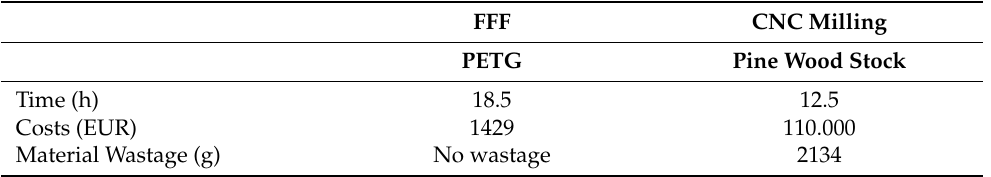
Table 4. Comparison between costs of CNC milling and FFF for the production of a column of the 17th-century